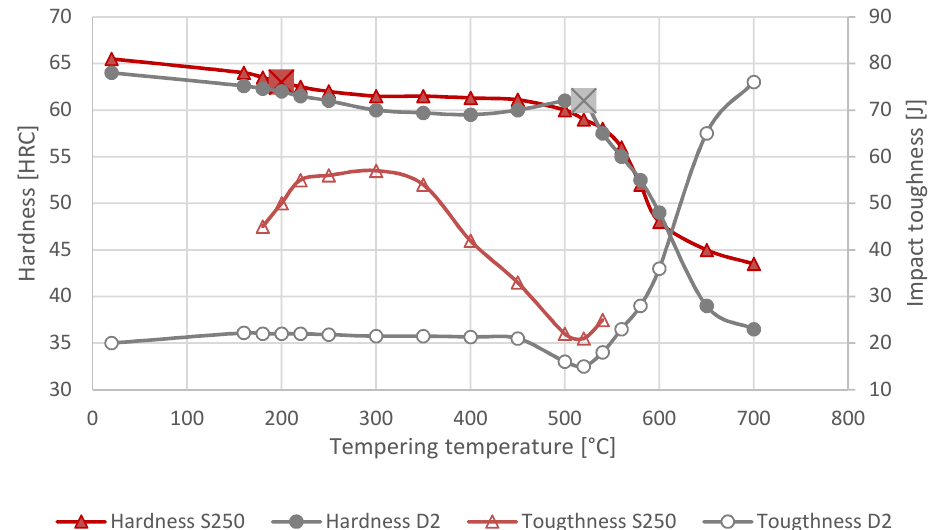
Figure 1. Tempering diagram of SIHARD S250 and commercial AISI D2 tool steels; Heat treatment conditions applied prior to testing are indicated with boxed X.